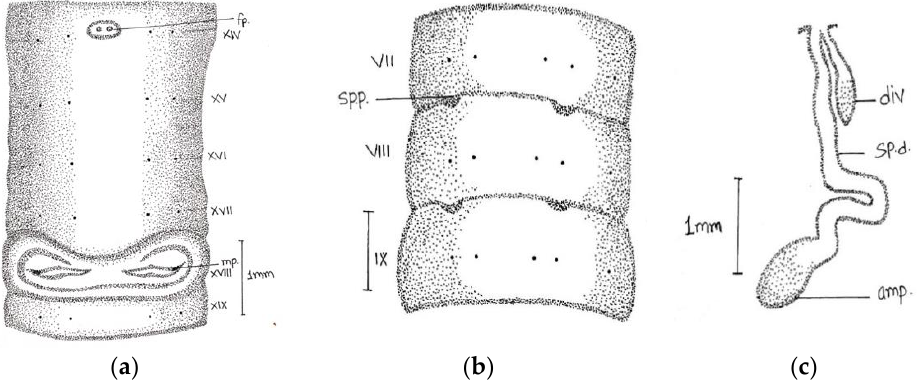
Figure 2. Camera lucida illustration of Megascolex auriculata ( a ) genital region; ( b ) spermathecal region; ( c ) spermathecae.